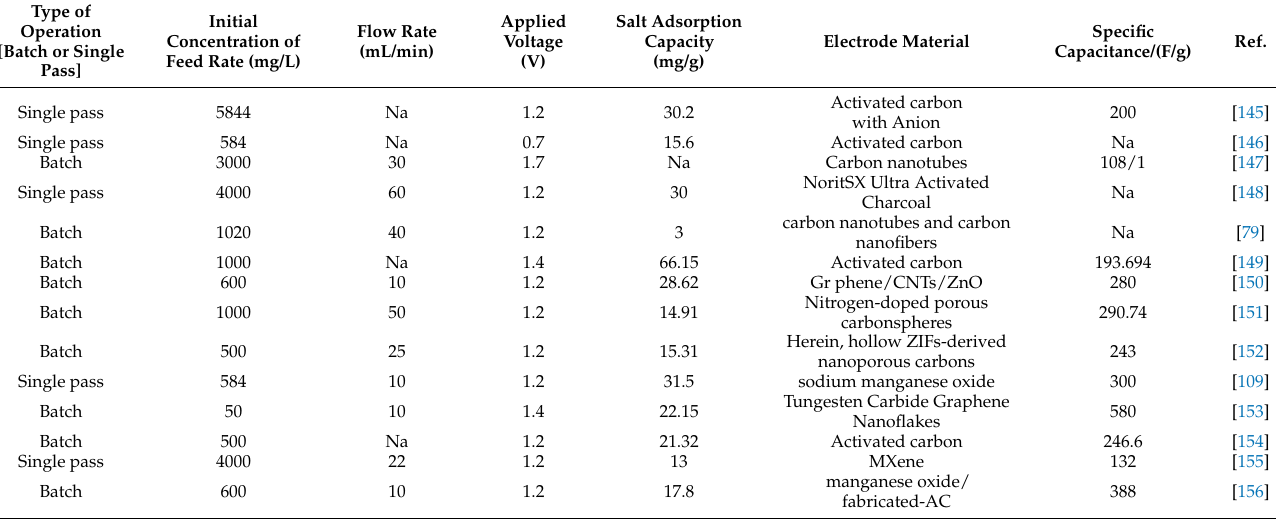
Table 2. Comparison of the Salt Adsorption Capacity (SAC) reported in the